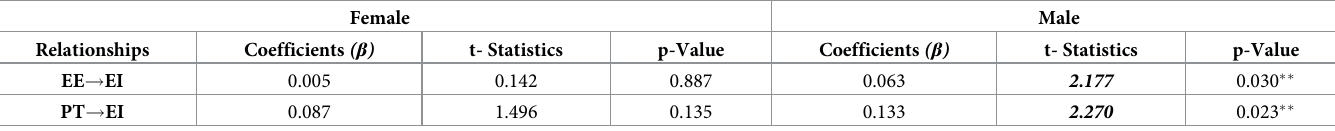
Table 7. Total indirect effects Male vs.